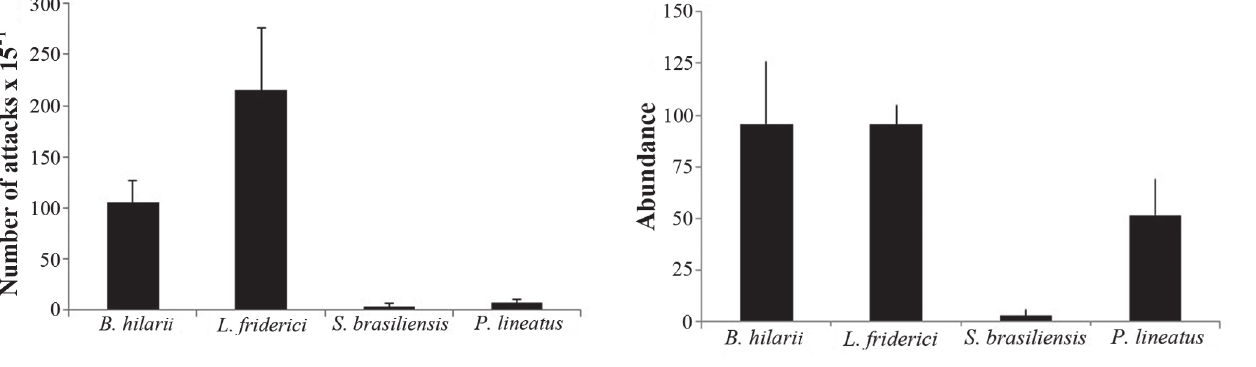
Fig. 3. Mean number (± SD) of attacks by Odontostilbe pequira towards larger fish during 15-min observation sessions of focal target species. N = 10.